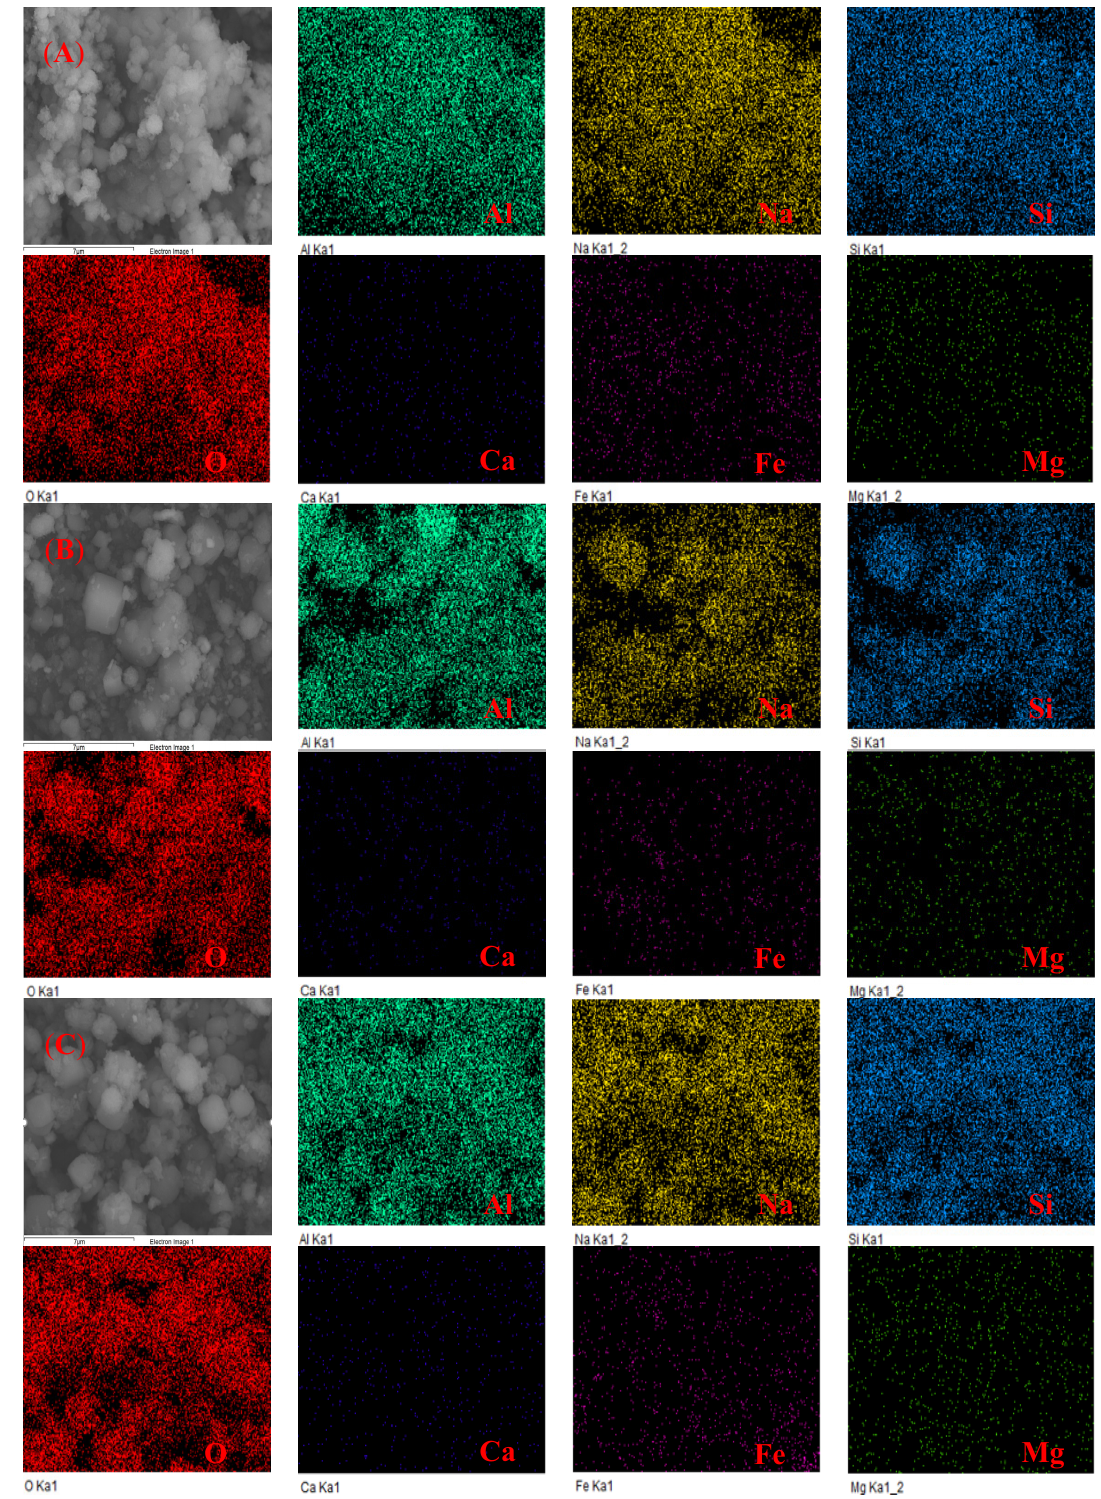
Figure 6. Elemental mapping of BFSZ synthesized at crystallization times of ( A ) 4 h ( B ) 6 h and ( C ) 8 h.